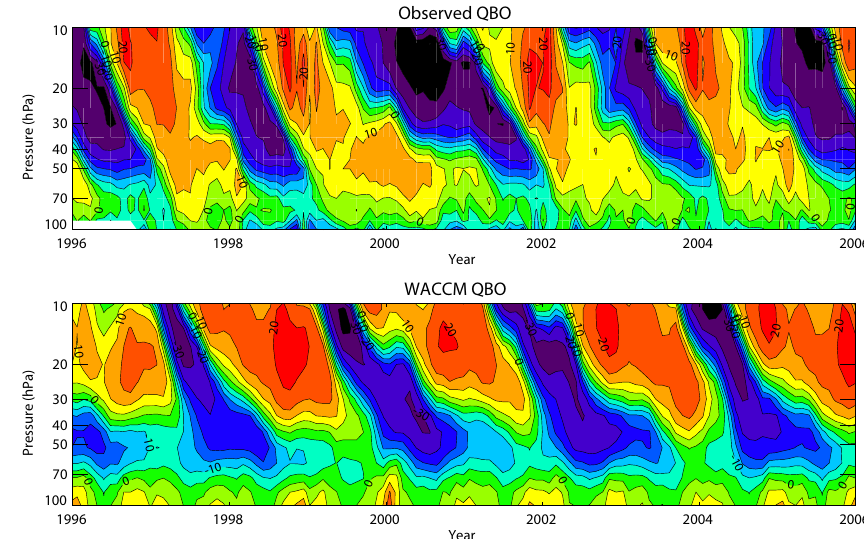
Fig. 1. Contour plot of the monthly mean equatorial zonal winds between 10 and 100hPa from both observations (top) over Singapore (1 ◦ N, 104 ◦ E) and the internally generated QBO in WACCM4a (bottom). Time period is from 1996 to 2006. Amplitude is in meters per second with contour interval of 5ms − 1 . Blue shading indicates QBO easterlies and red/orange denotes QBO westerlies. Singapore observations are available at